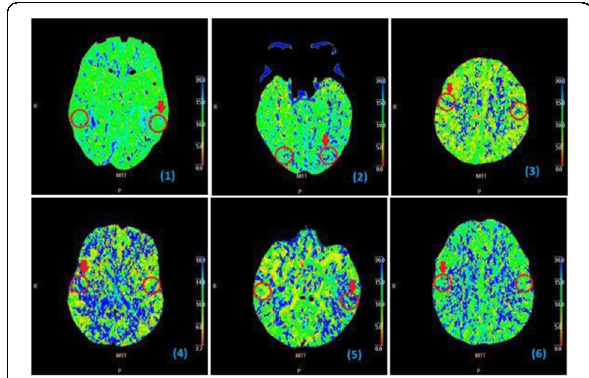
Fig. 1 (abstract P177). Perfusion Computed Tomography (Mean Transit Time images) performed during migrainous aura of the six patients. Circles with red arrows= symptomatic area; circles without red arrows= unaffected control area. Symptomatic area size= 1470 voxel